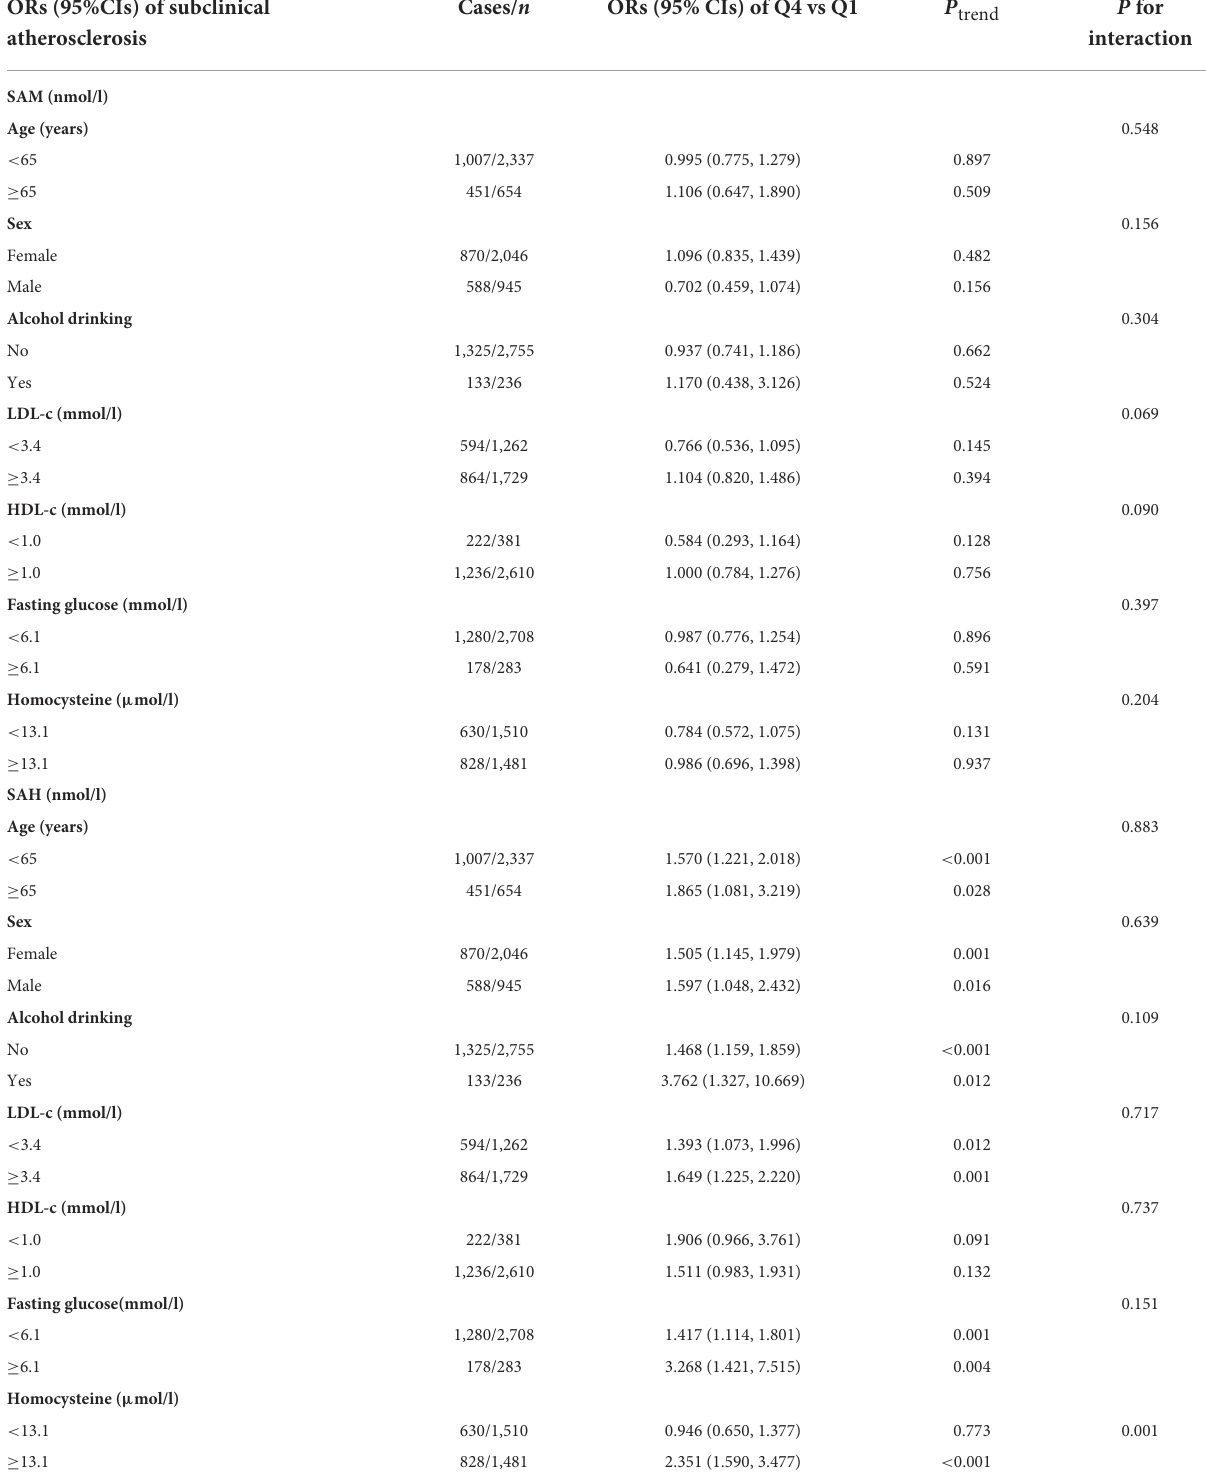
TABLE 5 Subgroup analyses by age, gender and selected cardiovascular risk factors on the risk of subclinical atherosclerosis according to the quartiles of serum C1 metabolites of the methionine cycle, Guangzhou Nutrition and Health Cohort ( n = 2,991) a . ORs (95%CIs) of subclinical Cases/ atherosclerosis